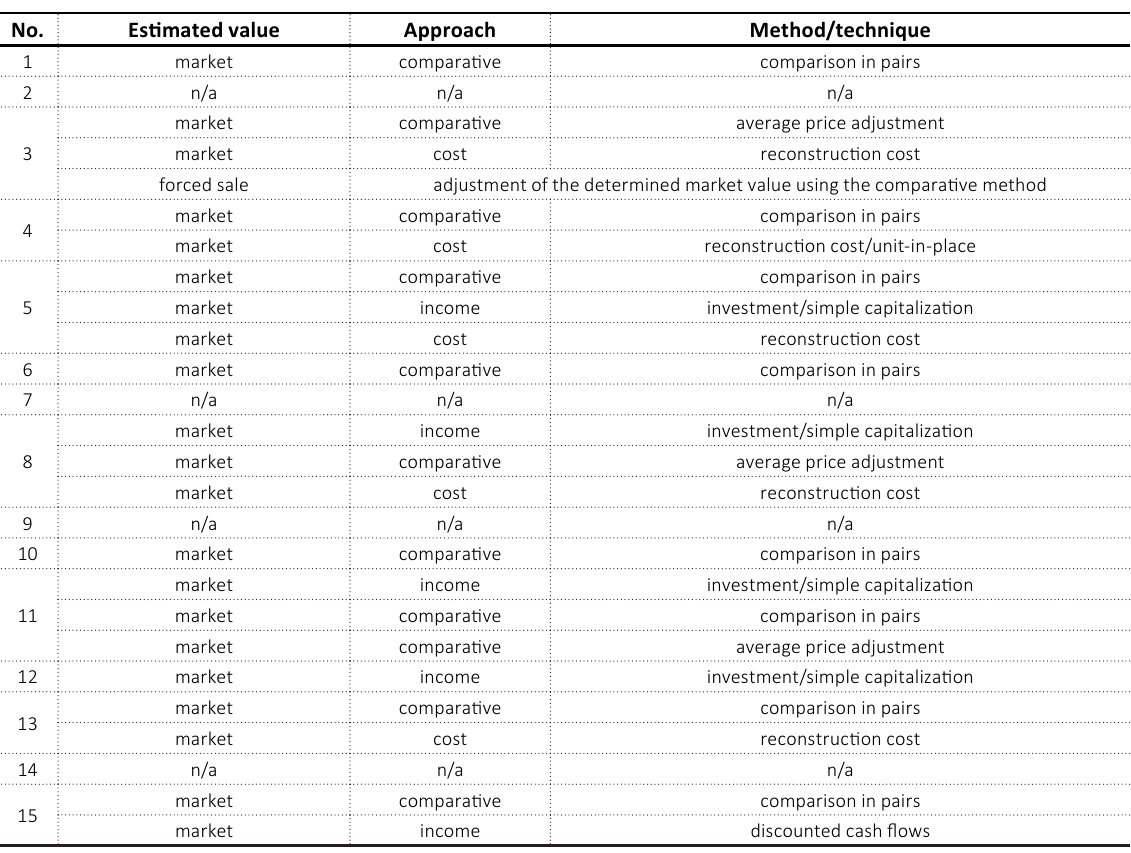
Table 2. Methods of valuation of real estate comprising the bankruptcy estate of the examined